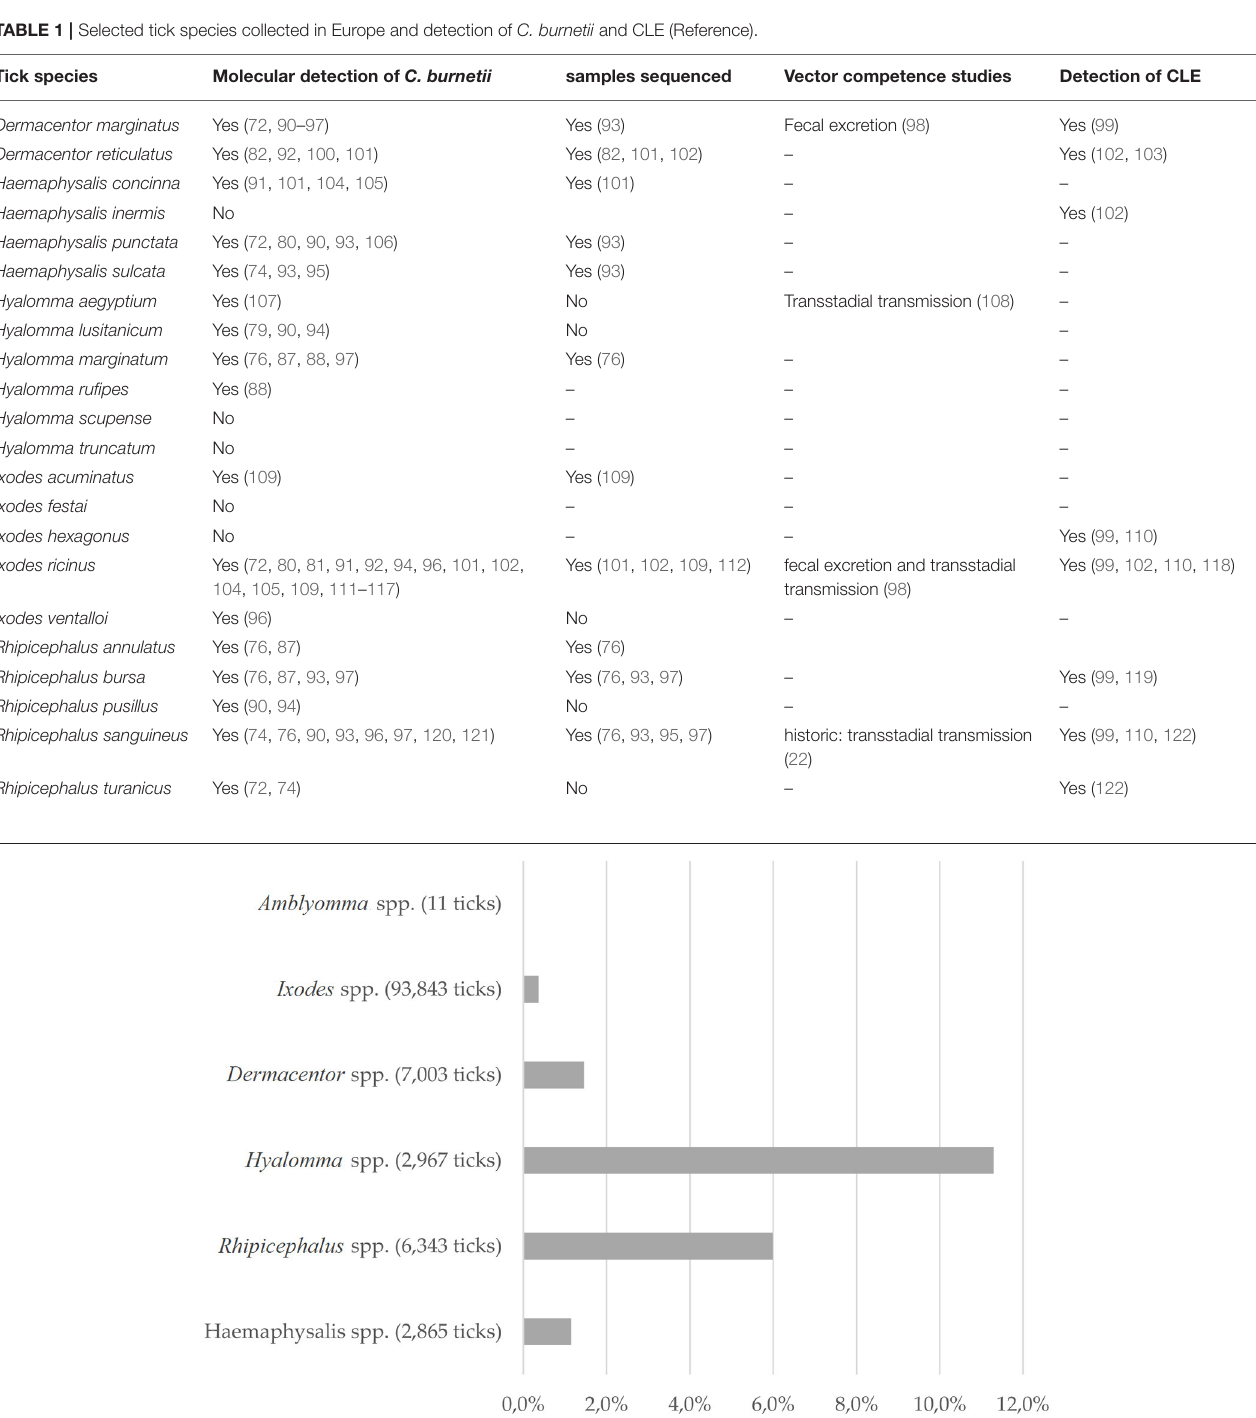
Experimental Vector Competence